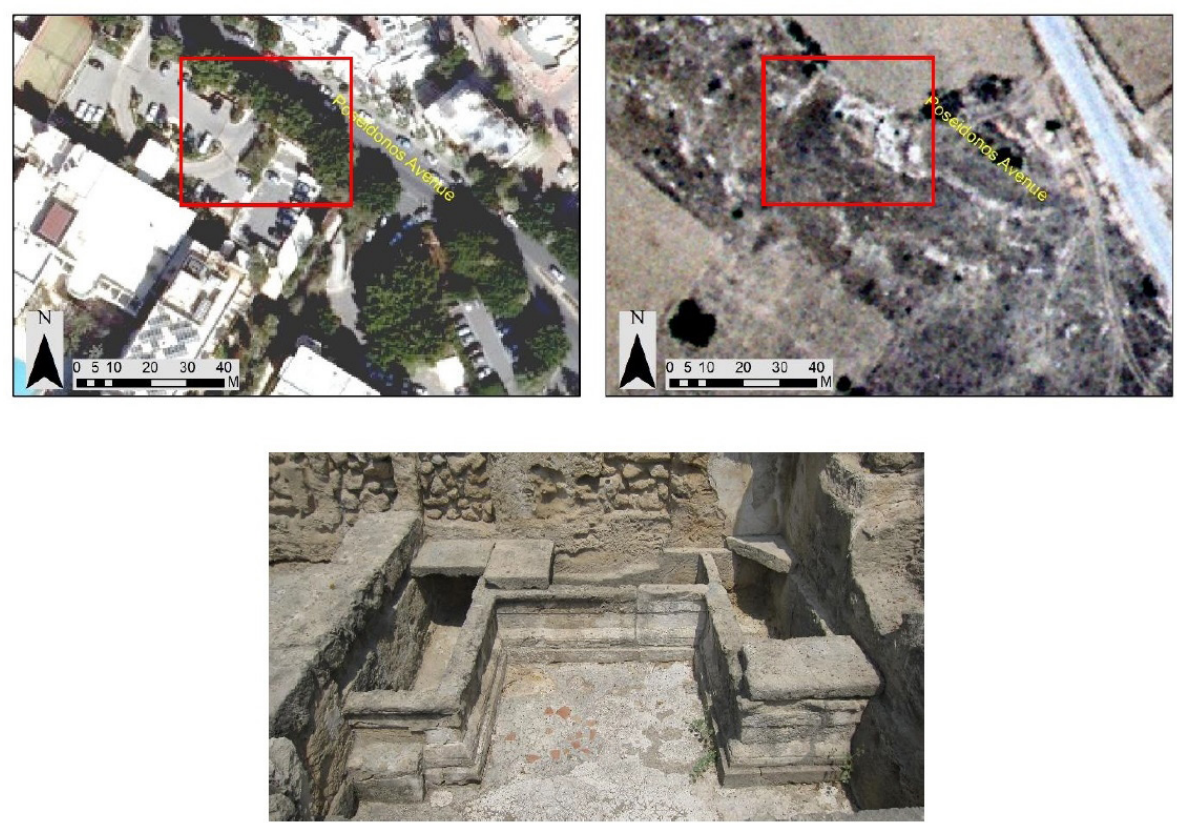
Figure 11: Aerial Orthophoto 2014; source: Department of Land and Surveyors, Cyprus) (left) and the 1968 aerial RGB (right). The rectangle refers to bottom picture, which shows a tomb partially preserved to this day within a private parking